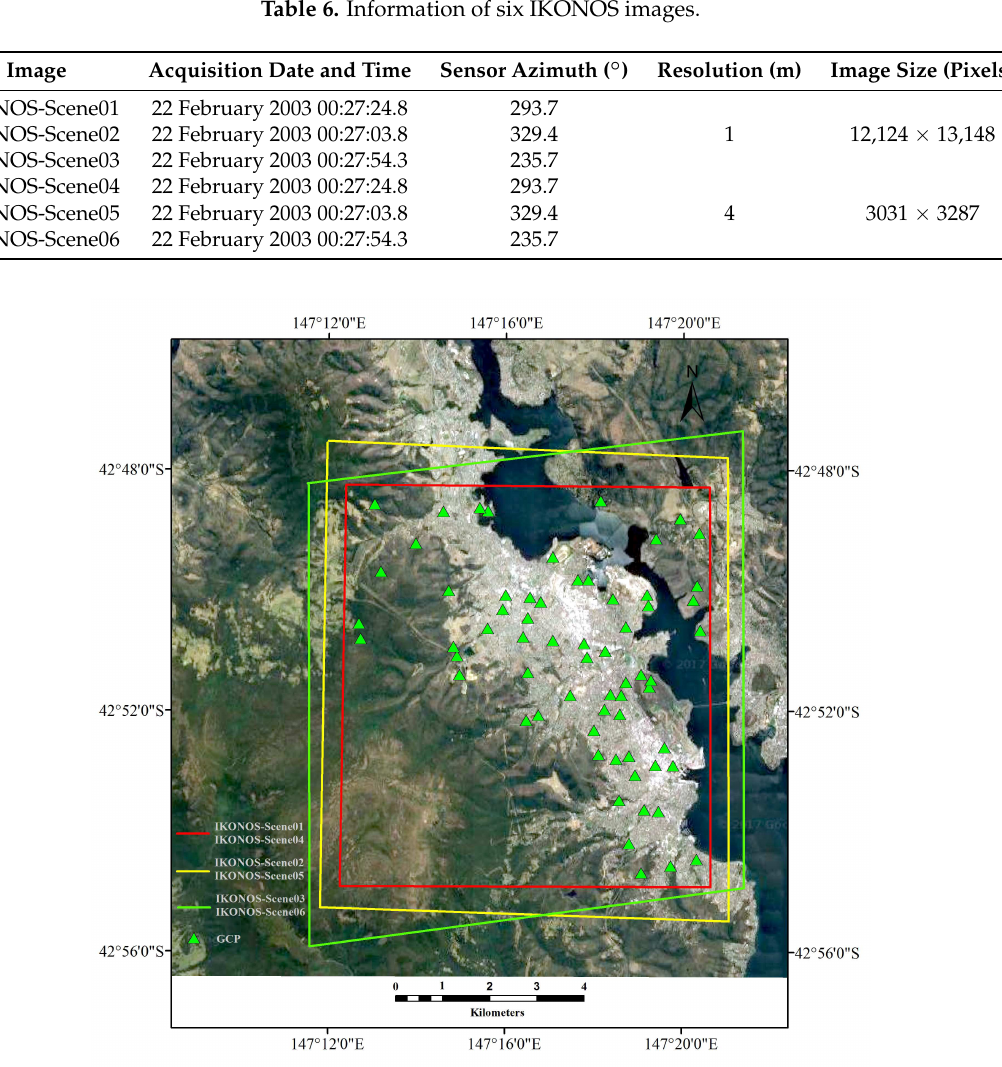
Table 6. Information of six IKONOS images.